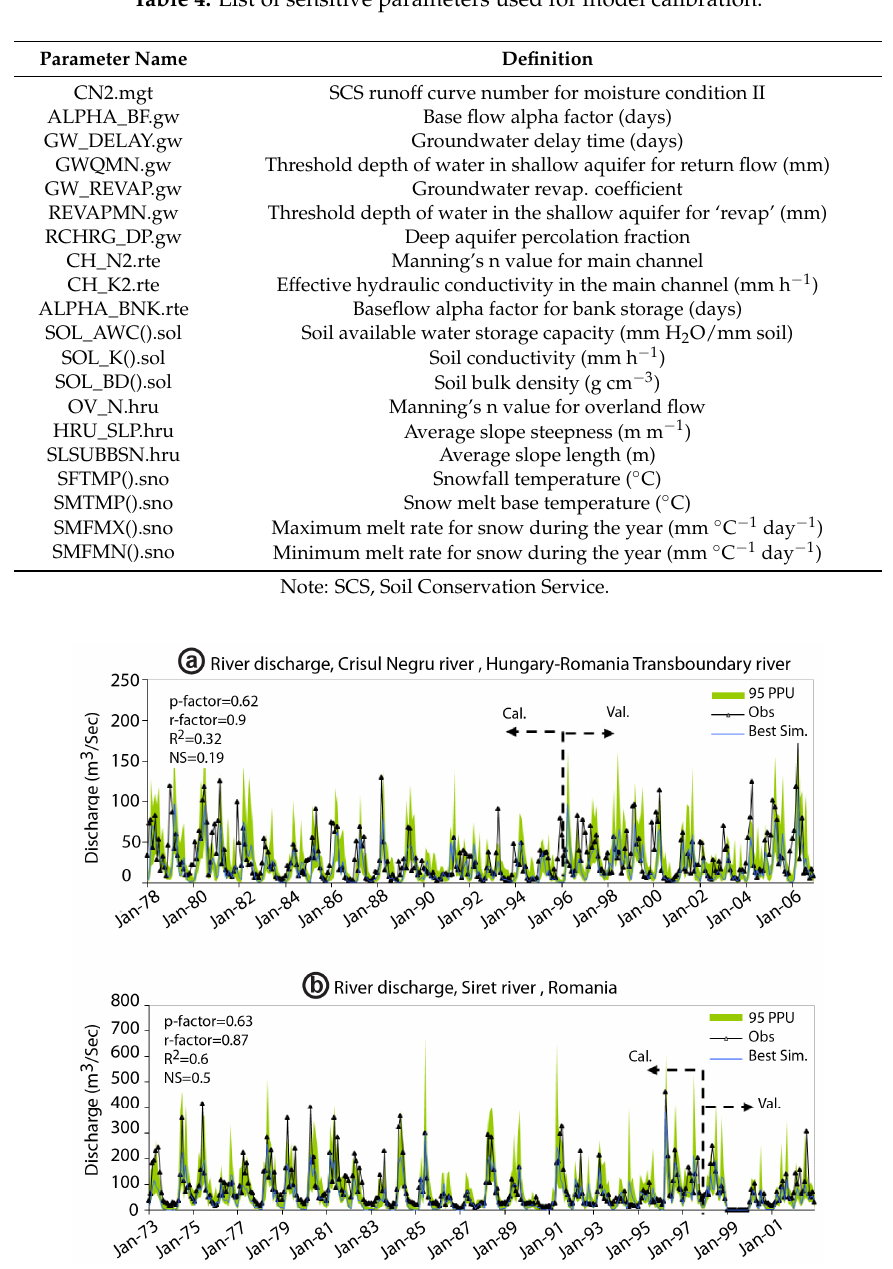
Figure 4. Simulated and observed river discharges of ( a ) Crisul Negru and ( b ) Siret river in the Black Sea Catchment (labeled in Figure 1). Shown in the picture are observation time series, best simulation along with 95% prediction uncertainty band (green band). The P-factor is the percentage of measured data bracketed by the 95 PPU band. It ranges from 0 to 1, where 1 is ideal and means all of the measured data are within the uncertainty band. The R-factor is the average width of the band divided by the standard deviation of the measured variable. It ranges from 0 to 1, where 0 reflects a perfect match with the observation. Based on the experience, an R-factor of around 1 is usually desirable. NS and R 2 are Nash–Sutcliffe efficiency and coefficient of determination, respectively.